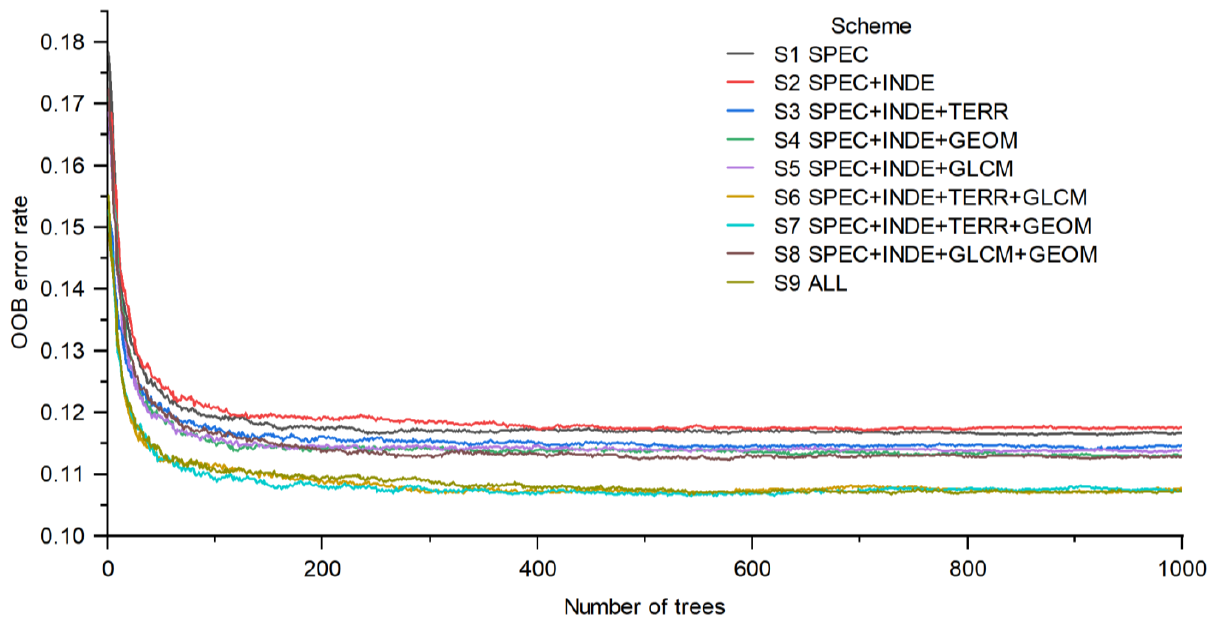
Figure 5. Conceptual flow of RF model. D is the training dataset.